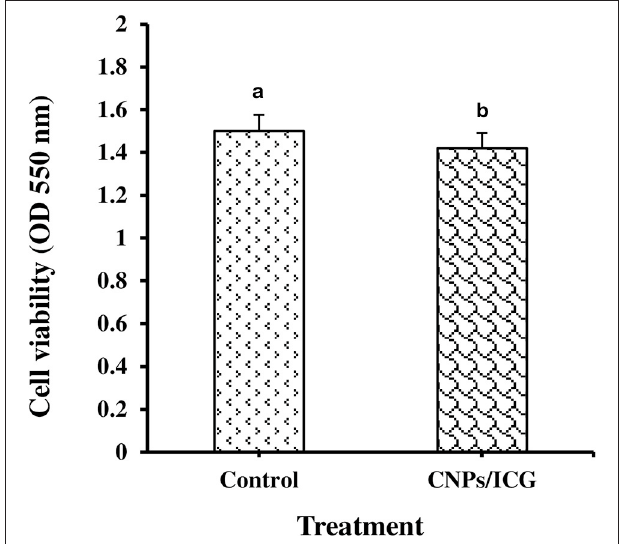
FIGURE 3 | Determination of HuGu cell viability by MTT assay; (a) Non-treated HuGu cells, (b) HuGu cells treated with CNPs/ICG.